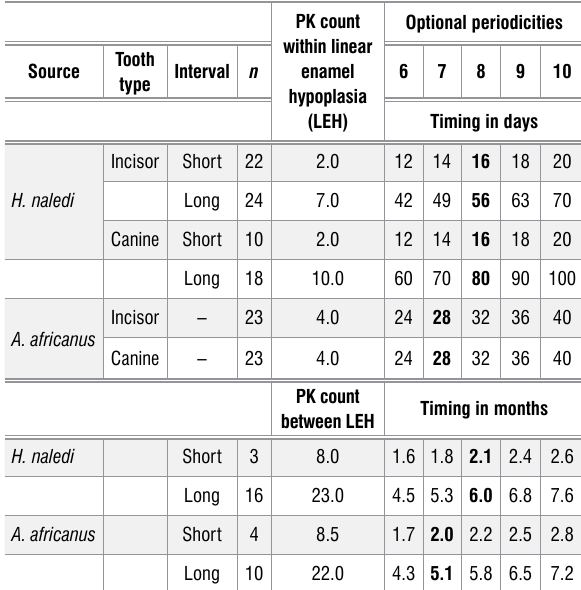
Reconstructed timing of defect durations (days)